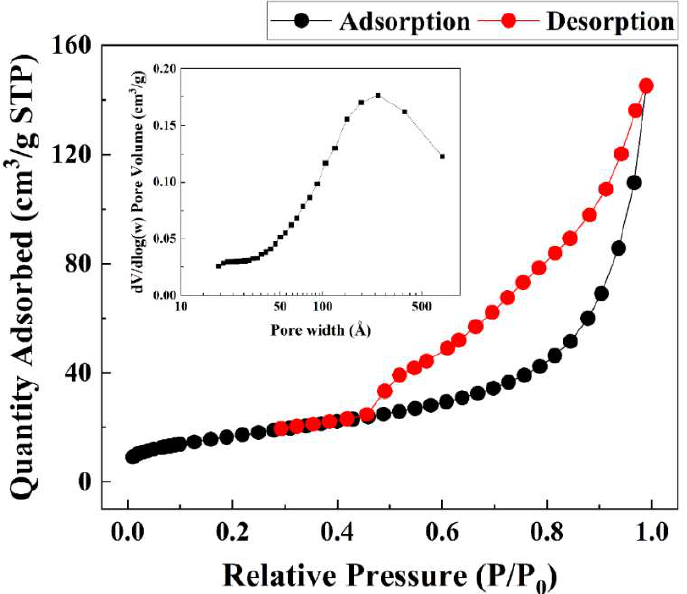
Figure 5. Nitrogen adsorption–desorption hysteresis loop of Alg–BO (inset graph shows the pore volume distribution).